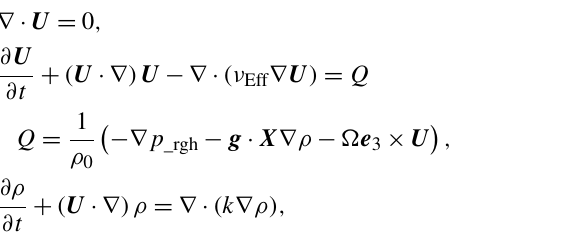
Table 1. Default values for ˆ O 1 and ˆ O 2